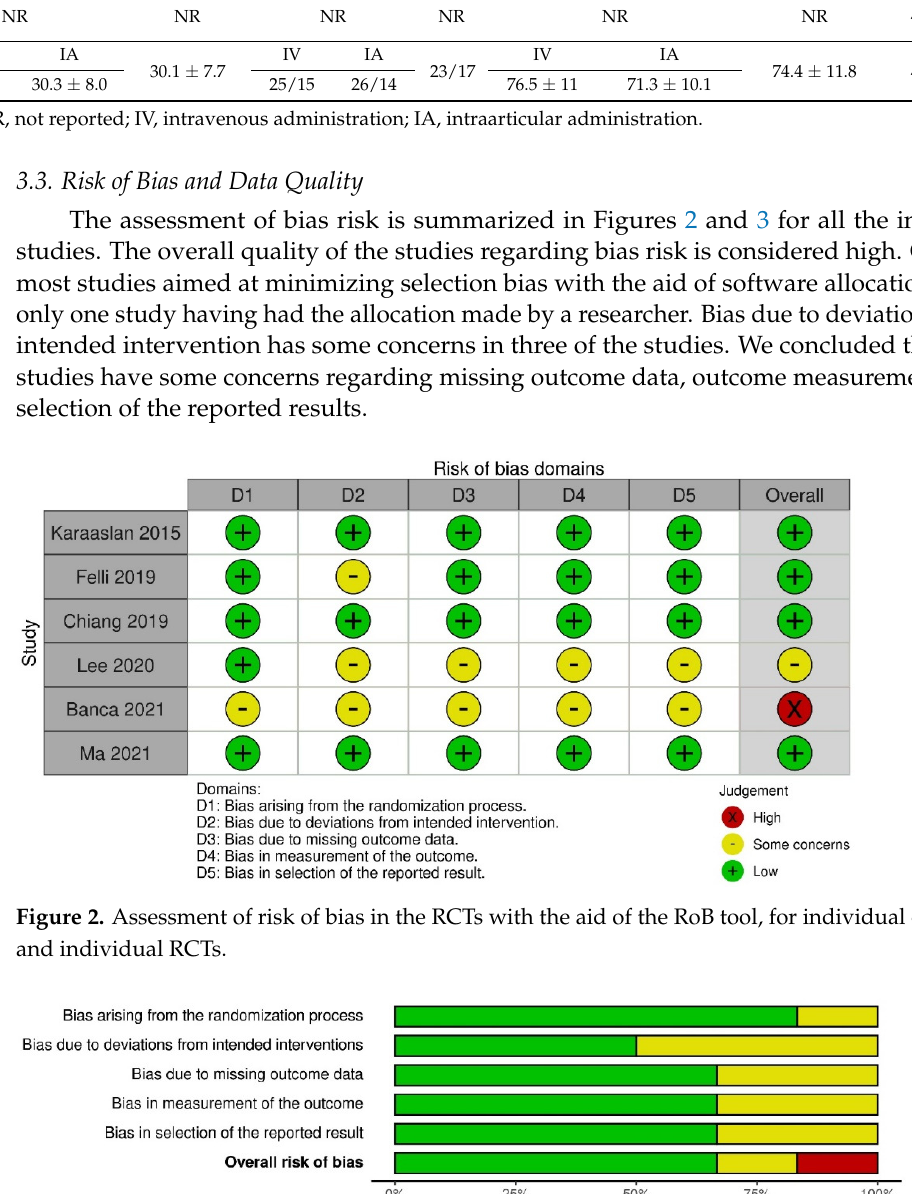
Table 1. Baseline characteristics and demographics of all included studies.